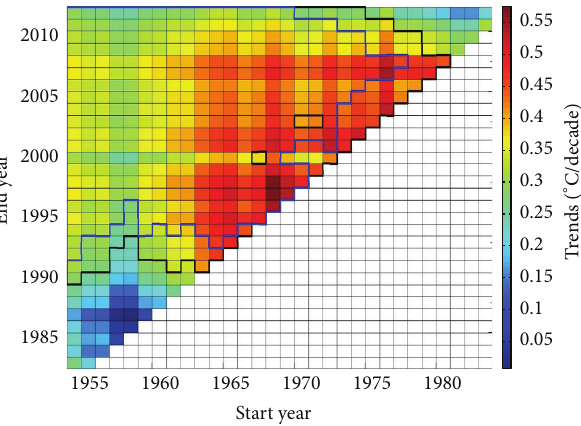
Figure 4: Multiple trend analyses for mean annual temperature of the Amur River basin. The color legend indicates the change in temperature in ∘ C/decade. Blue and black contours delineate areas of significant trends at 1 and 5% significance level, respectively.